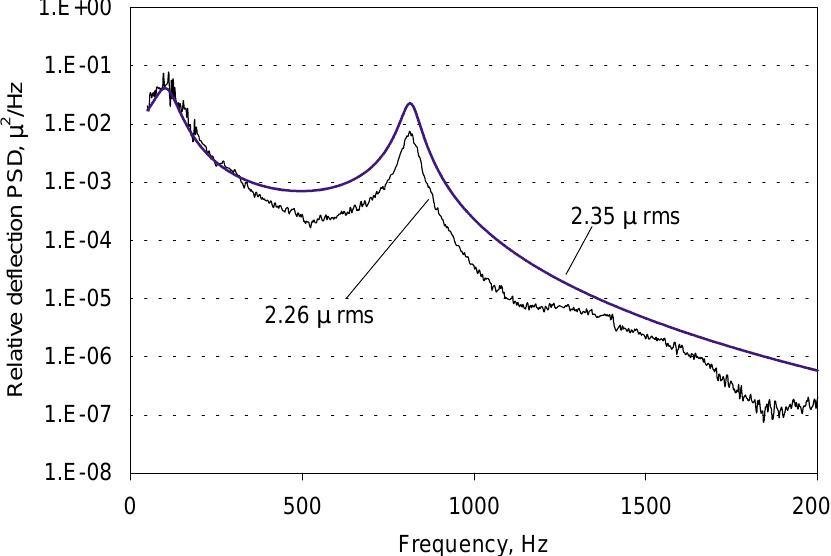
Fig. 19. Analytically predicted (2.35 µ rms) and experimentally measured (2.26 µ rms) dynamic response of